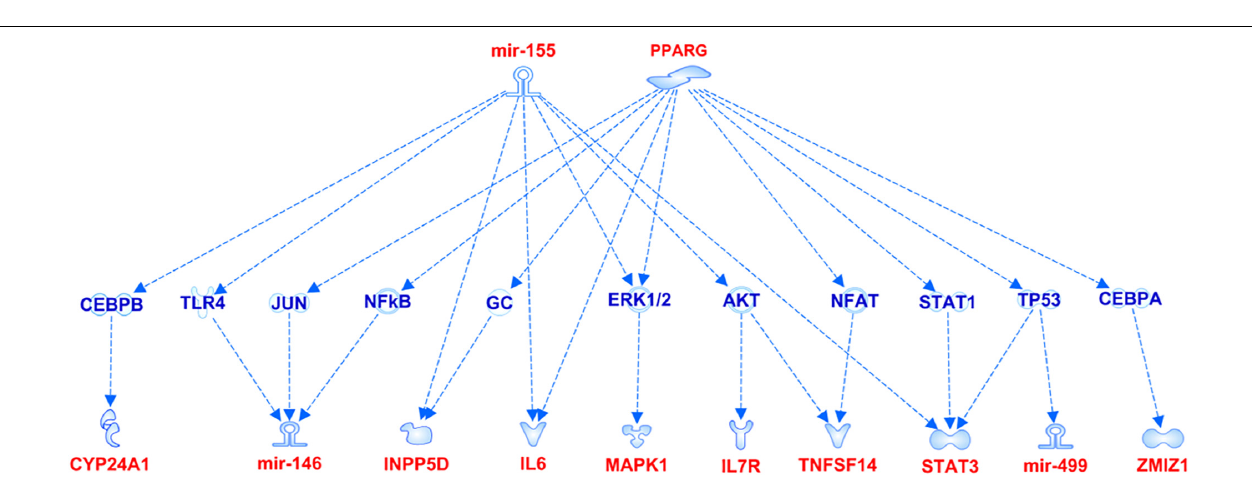
FIGURE 5 | miR-155 and PPARG signaling pathways showing the interaction with the genes associated with